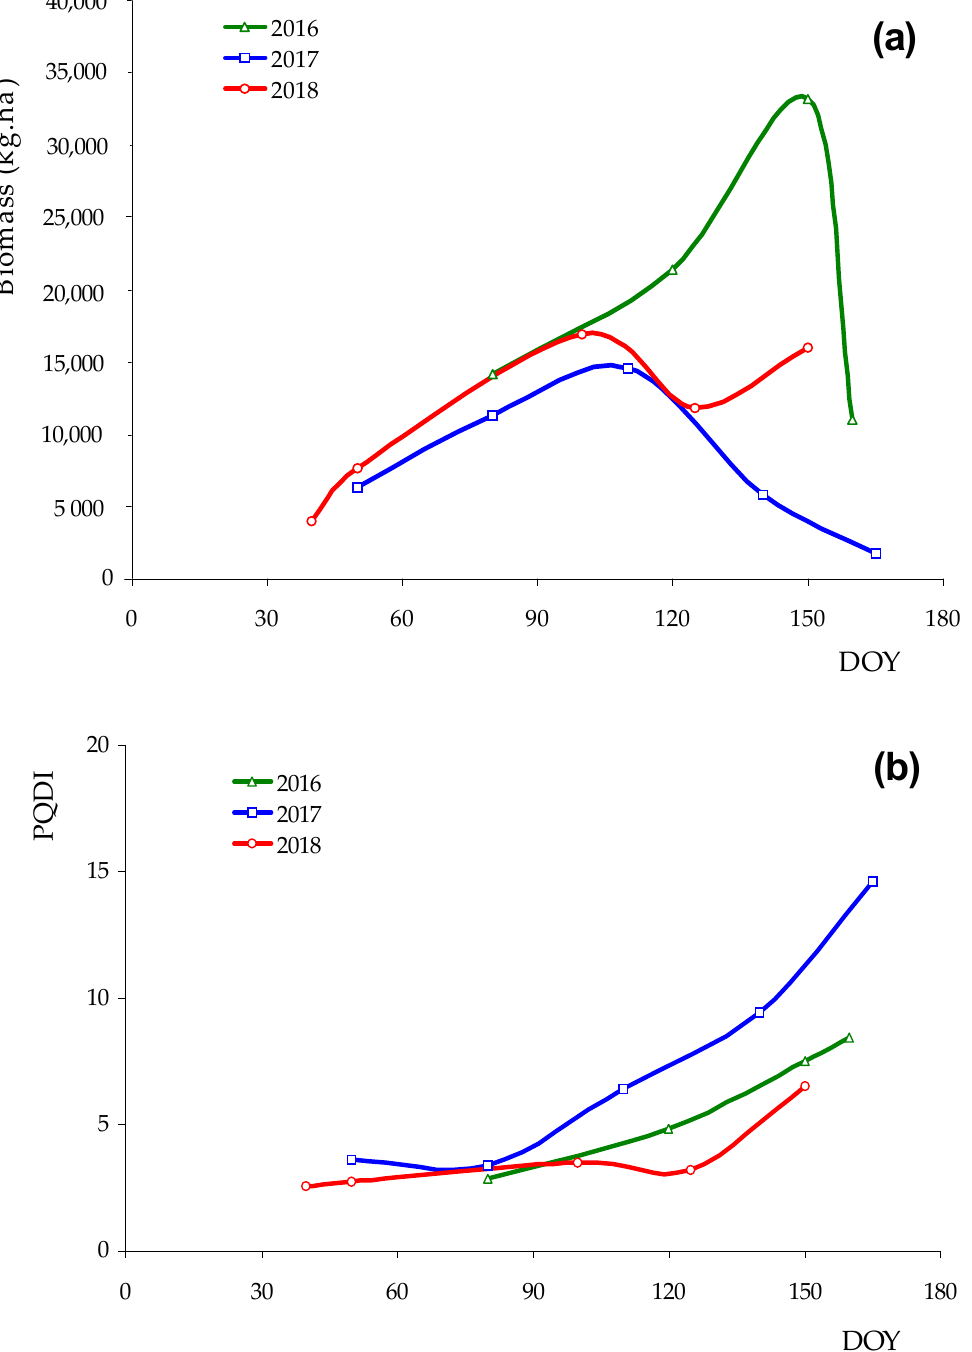
Figure 5. Evolution of pasture productivity (biomass, ( a )) and pasture quality degradation index (PQDI, ( b )) in three consecutive springs (2016–2018). Data are average values of the 12 sampling points.